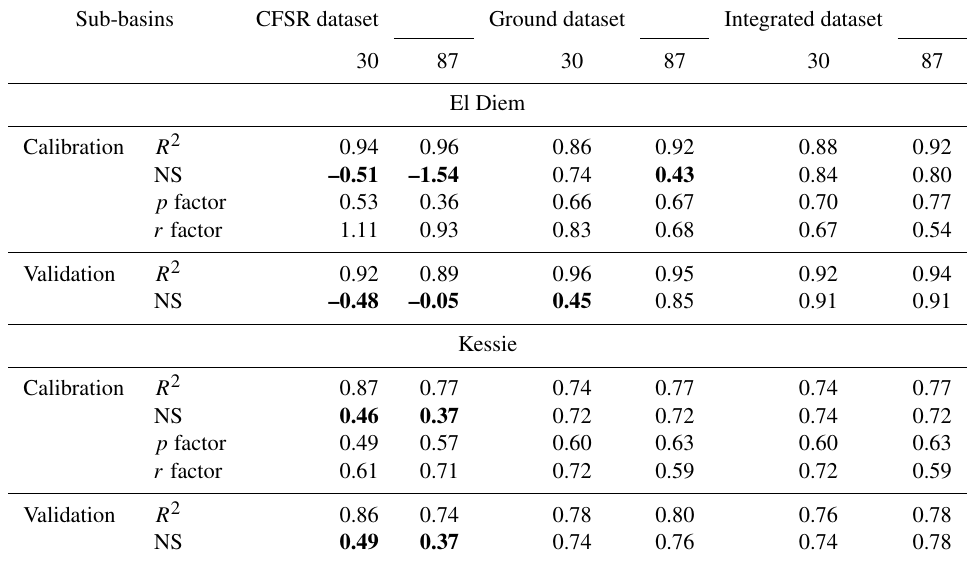
Table 4. Statistical results for the calibrations and validations with outflow data at the El Diem and Kessie gauging stations. Bold values mean “models with low performance”.